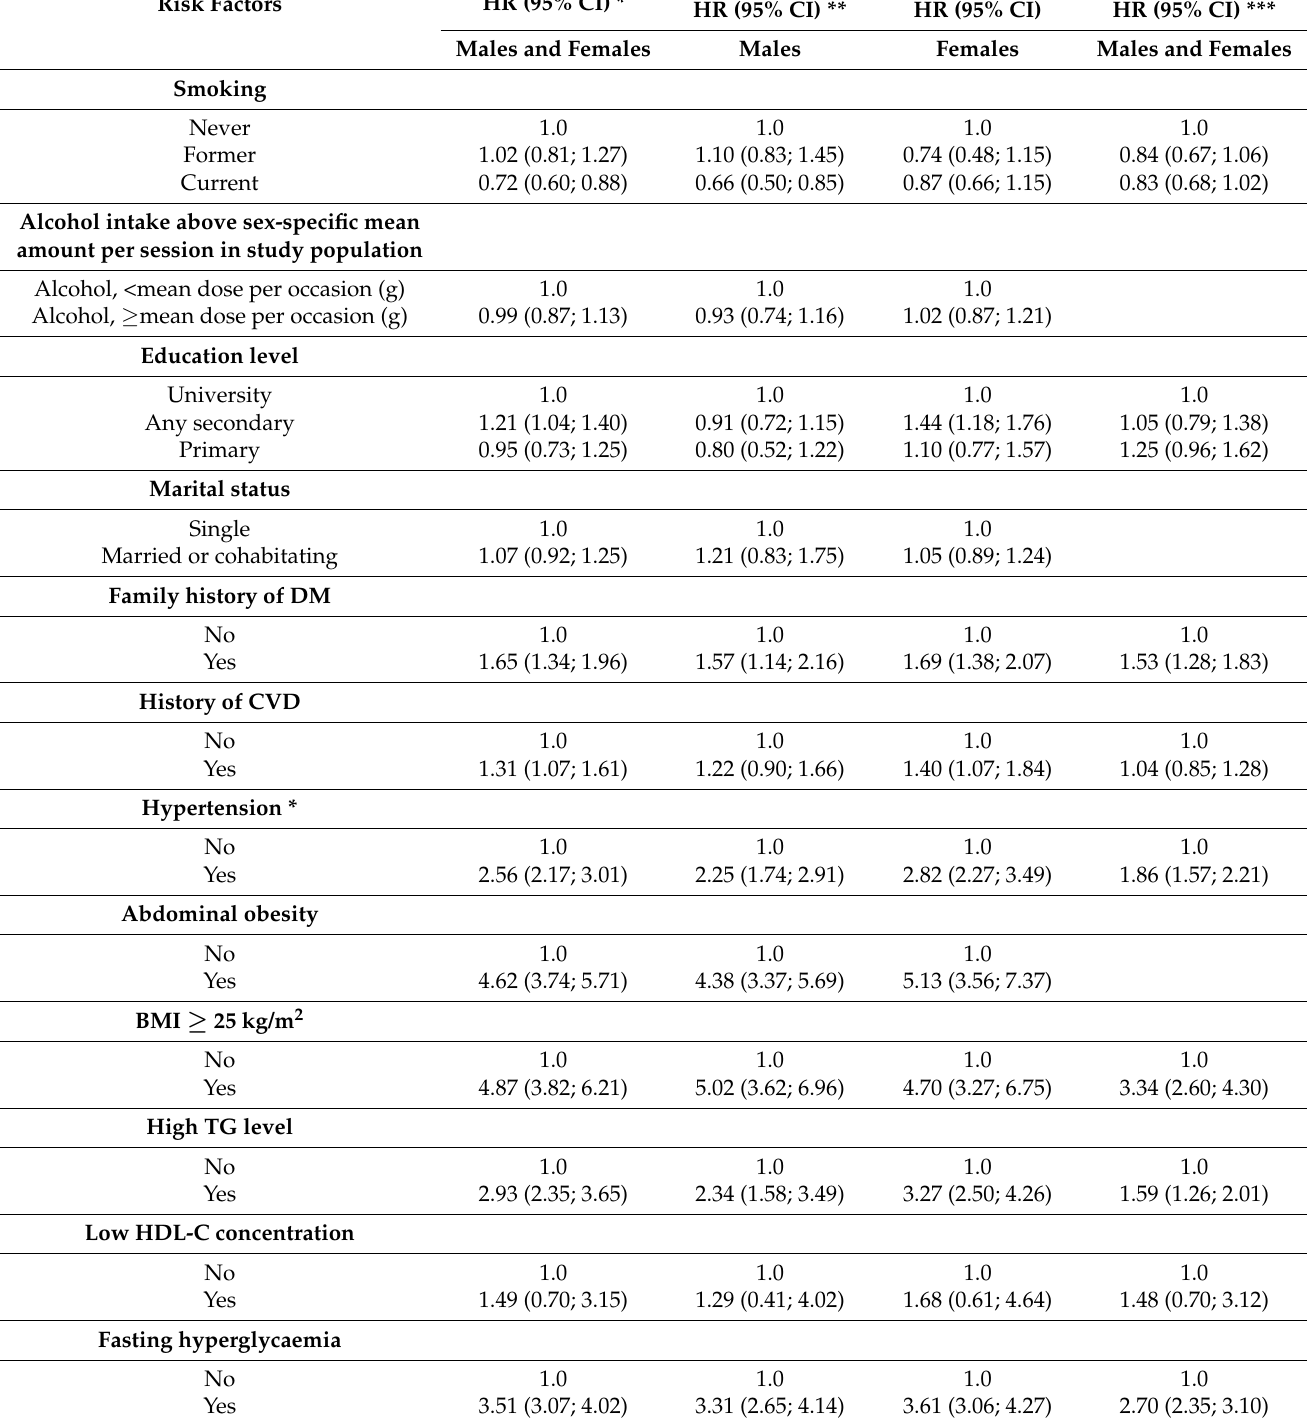
Table 3. The preliminary assessment of the relationship between the 14-year risk of T2DM and risk factors by age-adjusted and age- and sex-adjusted Cox